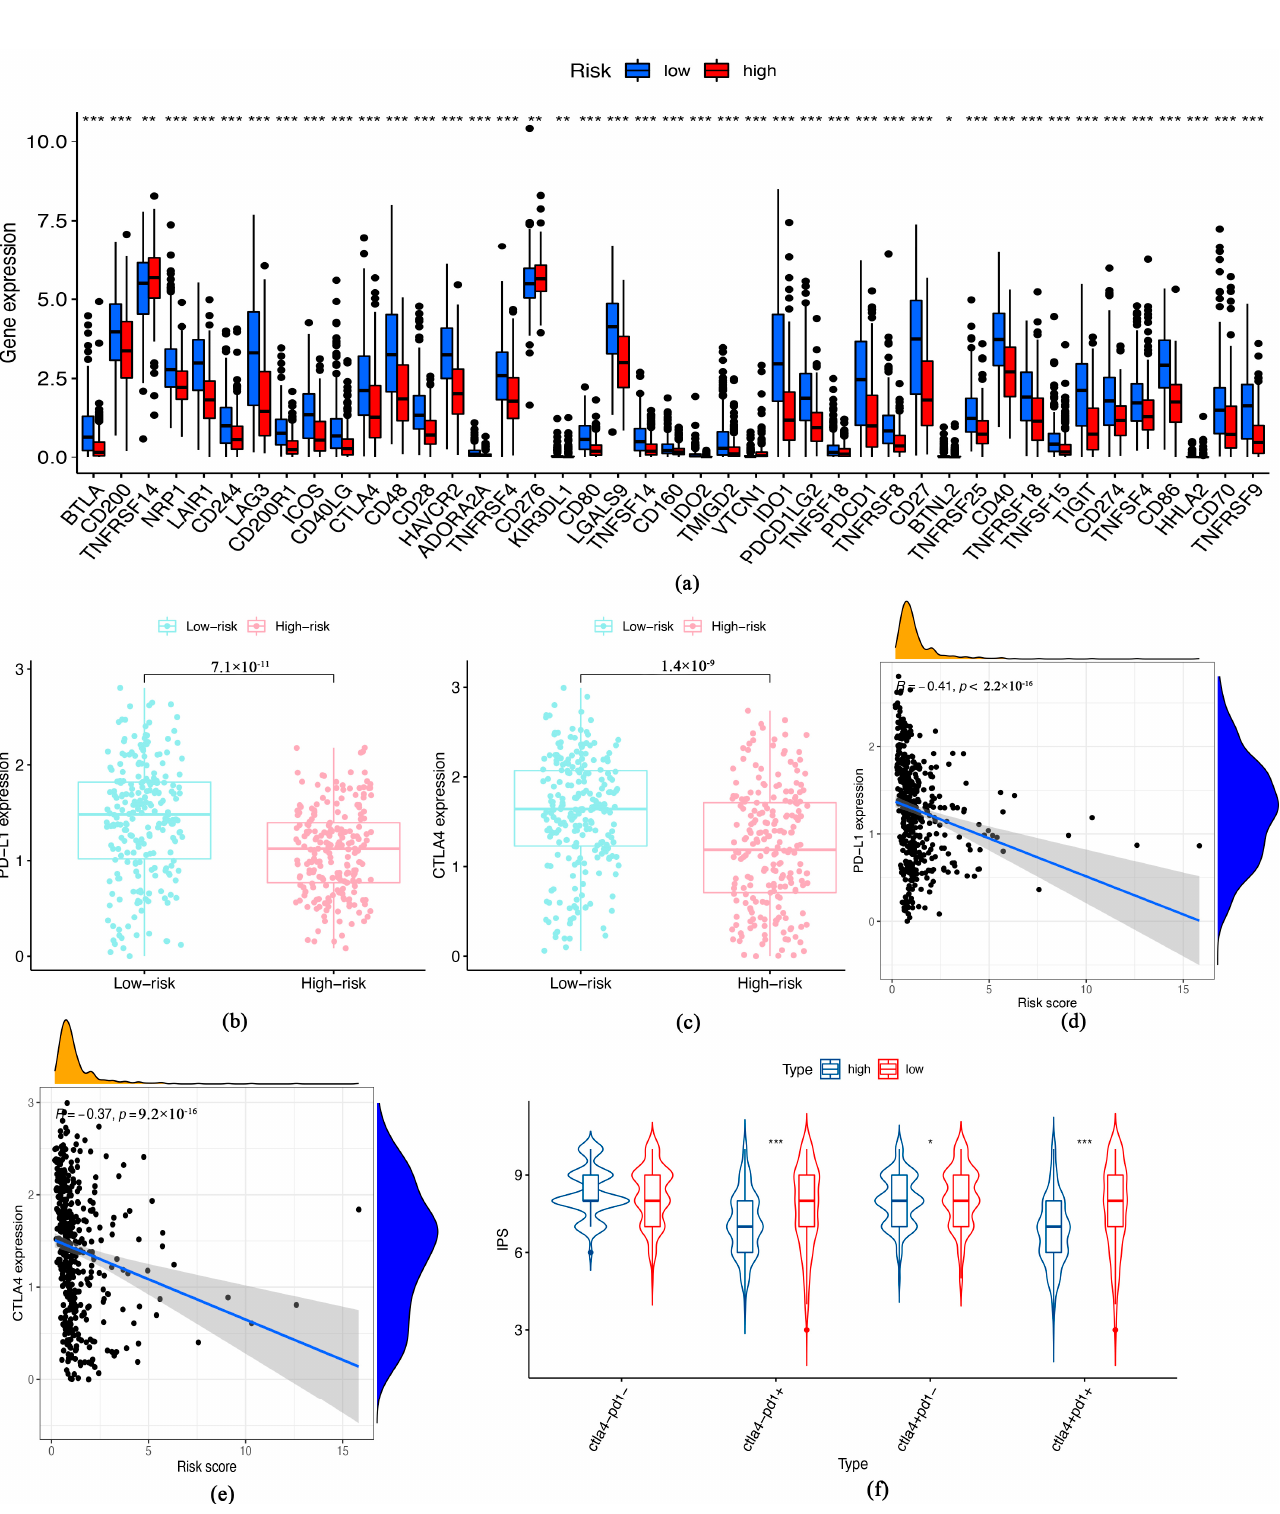
Figure 6. Exploring immune checkpoints and patient response to ICIs. ( a ) The di ff erence in the expression of immune checkpoint-related genes between the high and low-risk groups were examined by the Wilcoxon test. ( b , c ) Di ff erences in PD-L1 ( b ) and CTLA-4 ( c ) expression levels in di ff erent risk groups. ( d , e ) Analysis of the correlation between risk score and PD-L1 ( d ) and CTLA-4 ( e ). ( f ) The score of IPS with PD-L1, CTLA4, CTLA4, and PD1 blockers. p values were shown as: * p < 0.05; ** p < 0.01; *** p < 0.001.